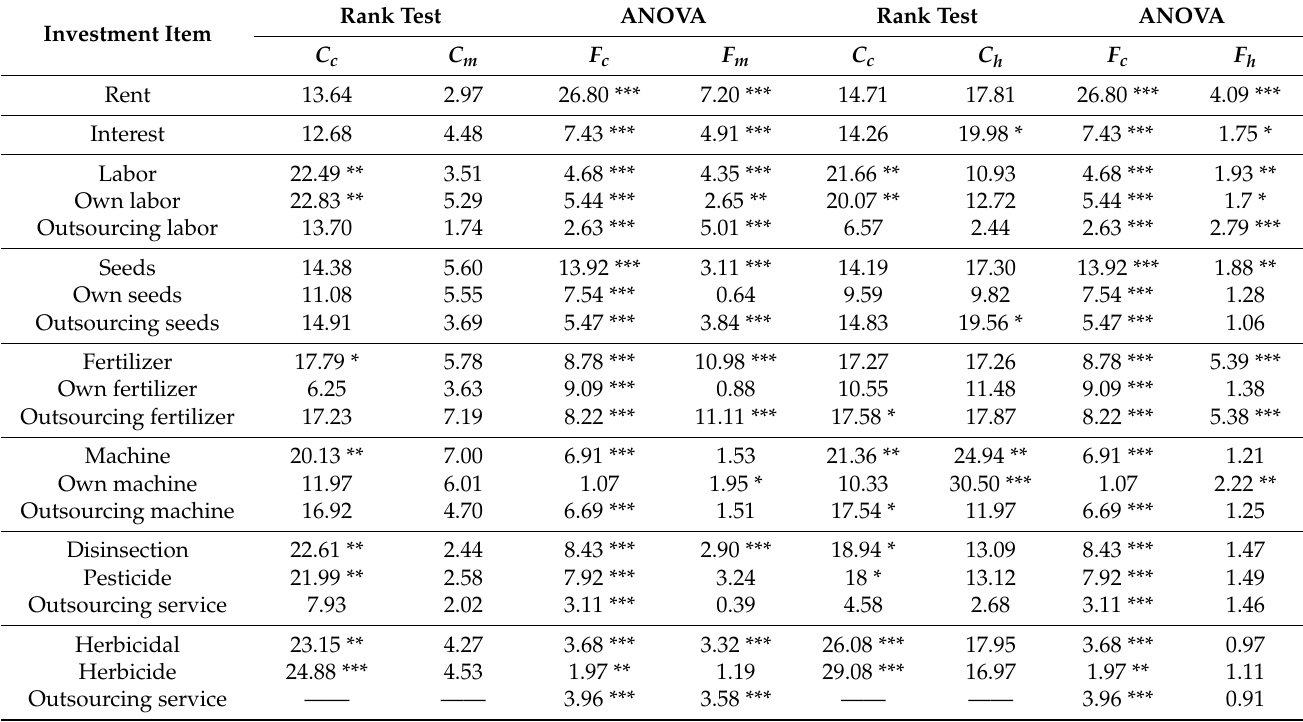
Table A1. Transaction Costs versus Memory and Body Mass Index Comparisons Using Two-factor Rank Test and